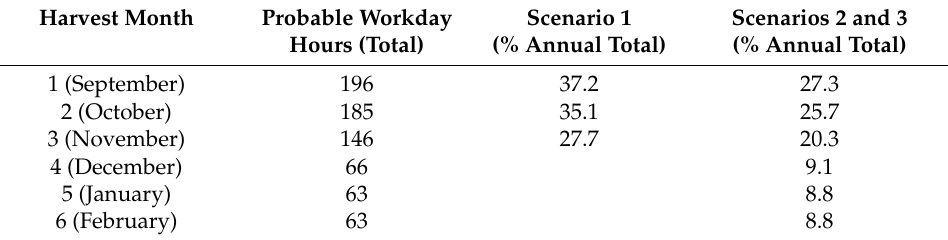
Table 1. Expected monthly workday hours in Lynchburg, VA, USA [54]. Harvest